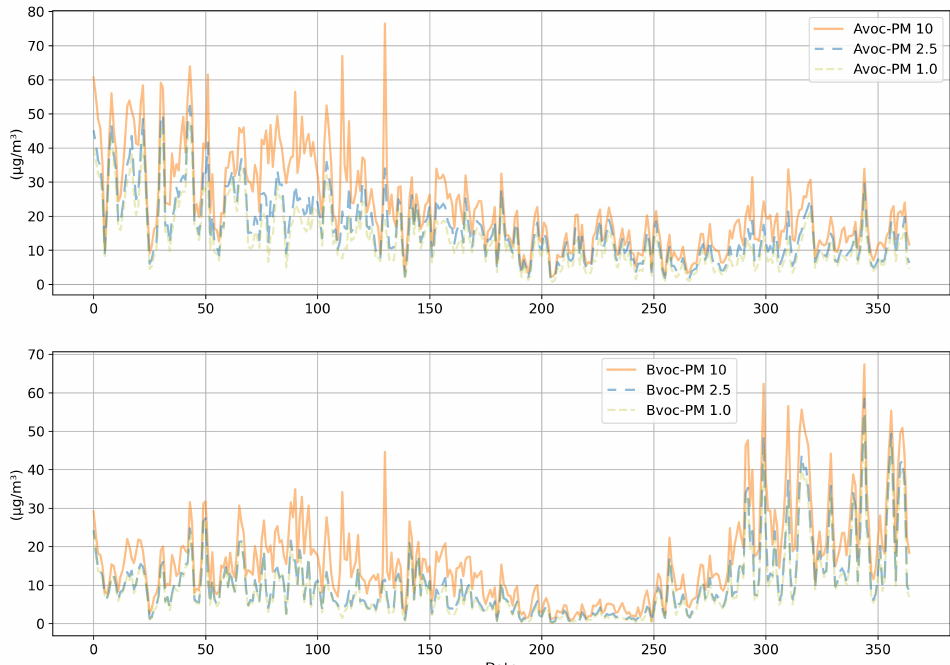
Figure 3. Average PM concentration data of Locations A and B.